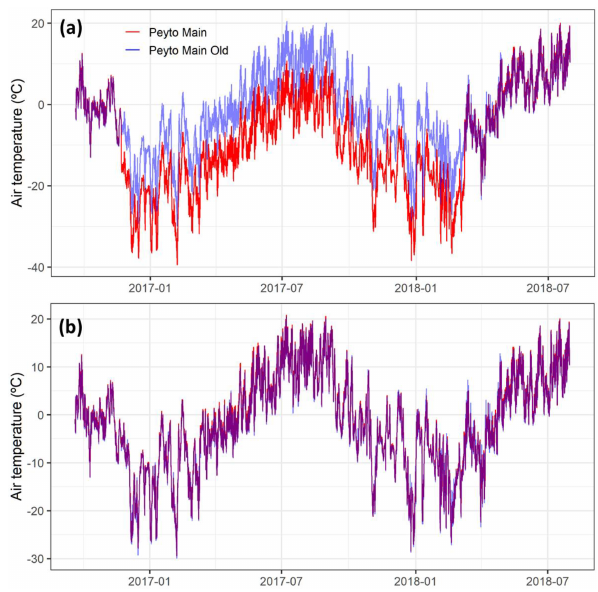
Figure 12. Air temperature recorded at the Peyto Main and Main Old stations: (a) before bias correction to Peyto Main, (b) after bias correction. Overlapping values appear in